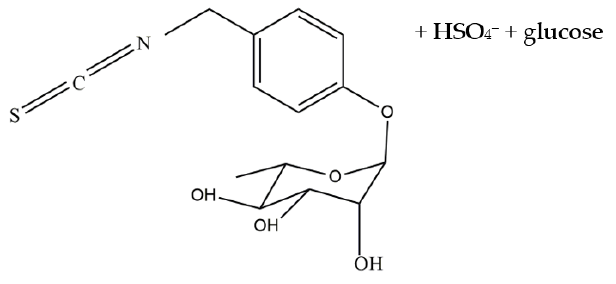
Figure 1. Structural formula of GMG-ITC.